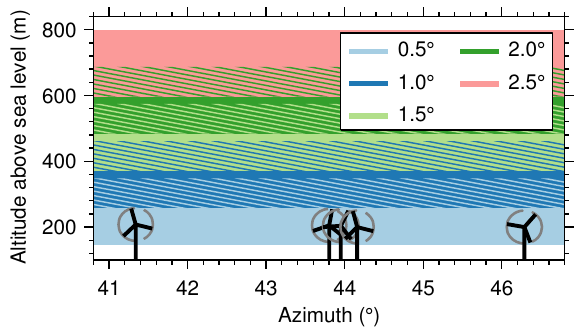
Figure 1. Schematic plot of the Brunsmo wind farm. The positions and heights of the wind turbines are shown together with the alti- tudes of the half-power beam width of the main radar lobe for the five lowest tilt angles (0 . 5 ◦ ≤ θ ≤ 2 . 5 ◦ ) at the wind